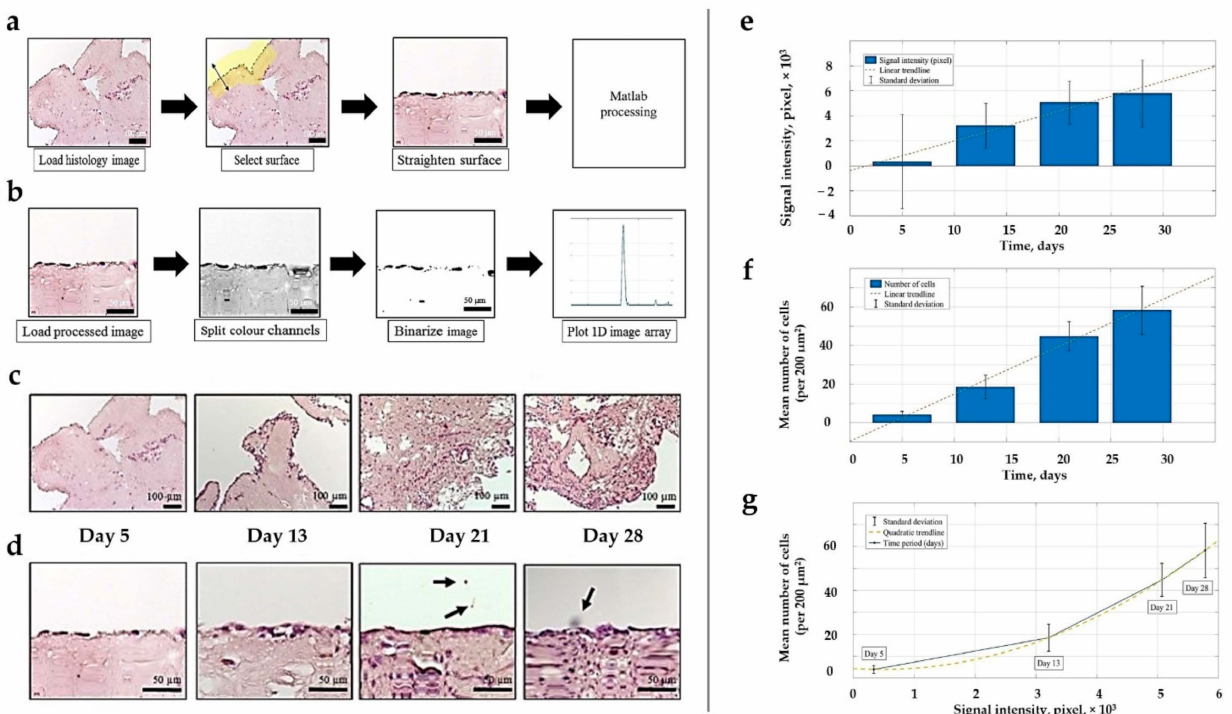
Figure A10. ( a , b ) The procedure of the digital image analysis of surface colonization pattern illustrated with a histology image of the CE liver/TNBC TECs at day 5 of the in vitro culture. ( a ) The first part of the algorithm is implemented in ImageJ and includes loading of image, selection of the surface area of 300 pixels in width, and straightening of the selected surface. The arrow on the yellow shade indicates a width of 300 pixels. ( b ) The second part of the algorithm is implemented in MATLAB and includes loading of the image processed in ImageJ, splitting of color channels, binarization of the green channel image with the with a threshold of 0.35, and creation of 1D image array, e.g., the image’s signal intensity is plotted versus the matrix depth in micrometers. ( c , d ) Distribution of the cells near the surface of the TECs over a period of 28 days. ( c ) Original histology images and ( d ) corresponding images of the digitally straightened and analyzed surface areas of the TECs. Arrows indicate sample impurities, which may occur during sample preparation. ( e – g ) Results of the digital image analysis of the TECs’ surfaces colonization patterns. Note the linear growth of cellular density near the TECs surfaces over the observation time. ( e ) Signal intensity in the surface areas of the TECs over the time (28 days). ( f ) Average number of cells per 200 µ m 2 in the surface areas of the TECs over time (28 days). ( g ) Average number of cells versus signal intensity (pixel) at four different time points (5, 13, 21, and 28 days). Scale bars: ( a ) left and middle panels 100 µ m, and the right panel 50 µ m; ( b ) and ( d ) all panels 50 µ m; ( c ) all panels 100 µ